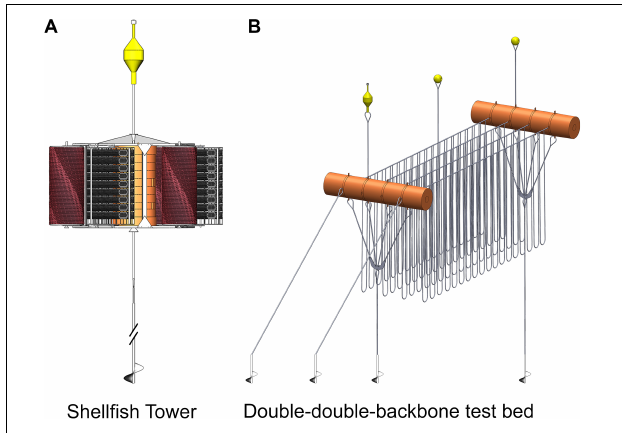
FIGURE 2 | (A) The shellfish tower device on the left and (B) the double-double-backbone test bed on the right.